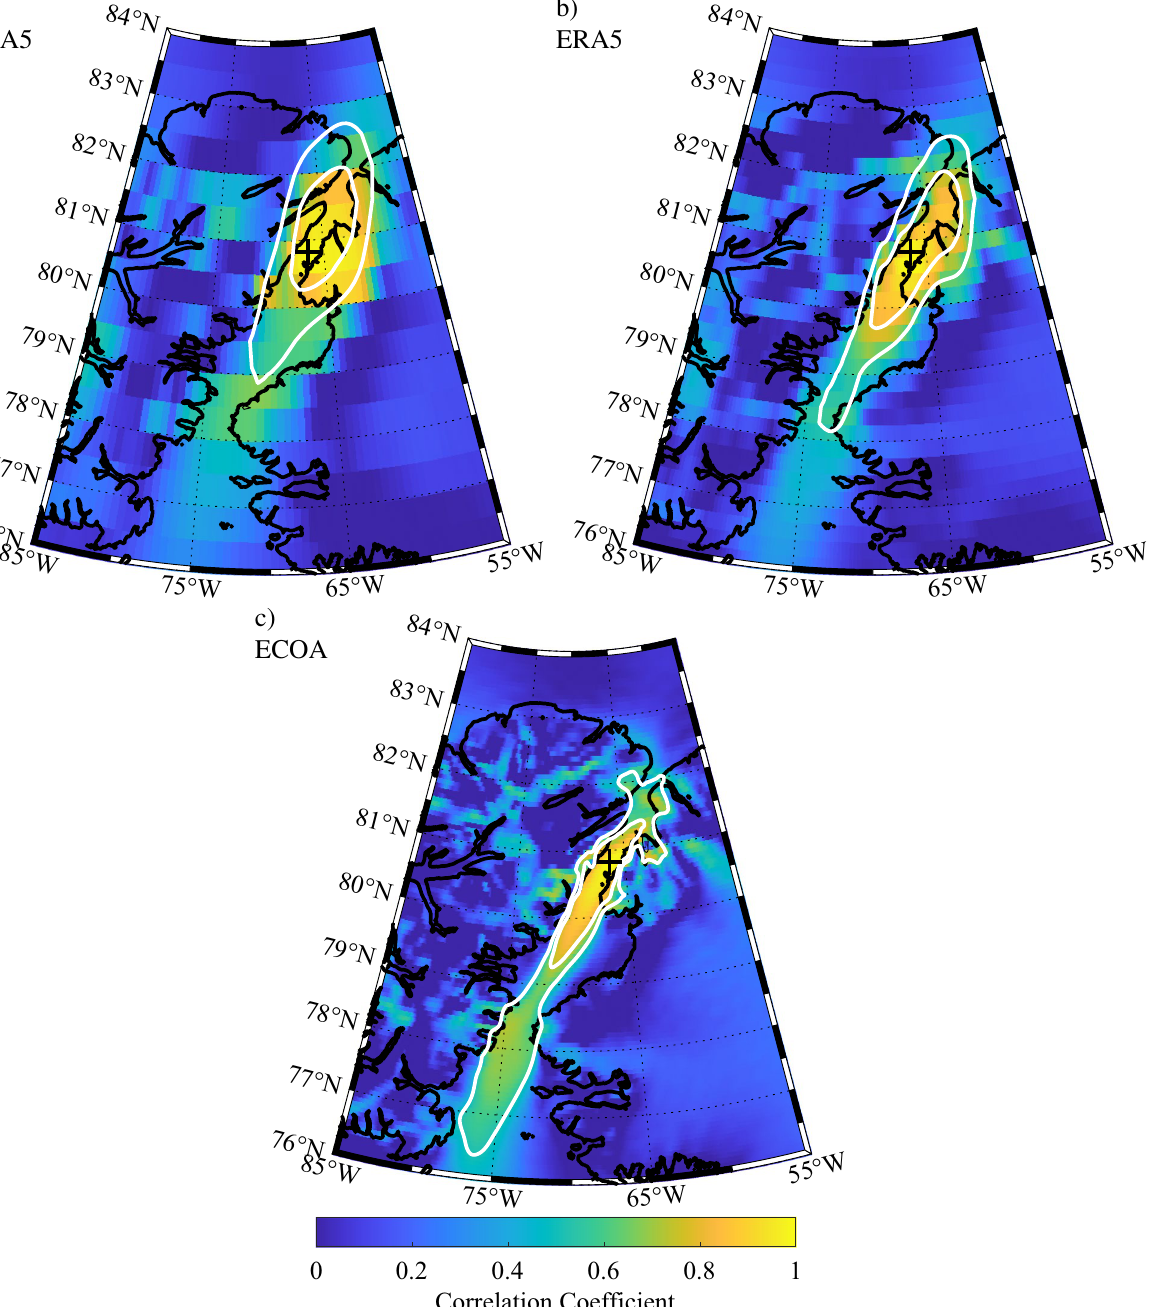
Figure 8. One-point correlation maps showing the correlation between the 10 m wind speed at Hans Island and at other gridpoints in the Nares Strait region as represented in the: (a) eERA5, (b) ERA5 and (c) ECOA for the period 2016–2020. The location of Hans Island is indicated by the ‘ + ’. The 0.5 and 0.7 correlation coefficient contours are shown in white. Figure created using Matlab R2019b (https:// www. mathw orks.